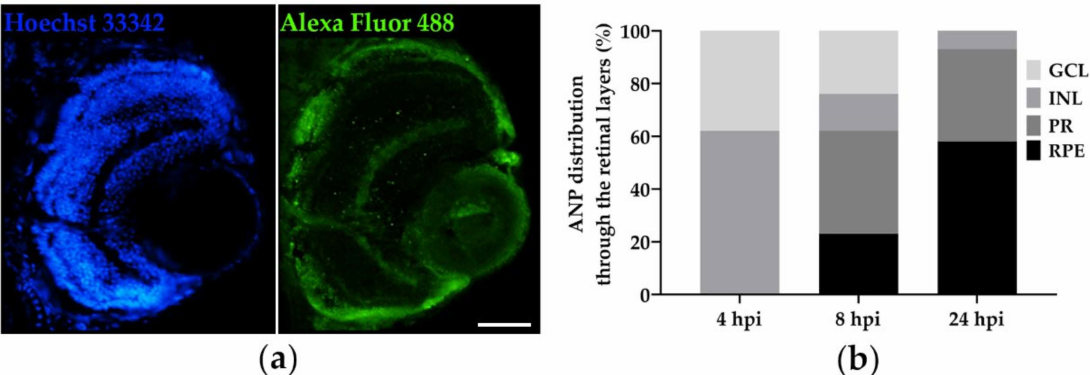
Figure 2. Nanoparticle distribution through retinal layers after intravitreal injection in zebrafish larvae. ( a ) Representative images of a retinal cross-section of a zebrafish larva IVT injected with Alexa Fluor 488-positive polyacrylamide nanoparticles, analysed at 4 h post-injection (hpi). Hoechst staining allows identification of the retinal layers. In FITC channel, the intense green spots clearly highlight the presence of Alexa Fluor 488-positive nanoparticles in the injected eye. ( b ) Quantitative evaluation of the distribution of Alexa Fluor 488-positive polyacrylamide nanoparticles in the retinal layers at different time points. n = 15 injected eyes from 3 independent experiments. GCL, ganglion cell layer; INL, inner nuclear layer; PR, photoreceptors; RPE, retinal pigment epithelium. Scale bar: 50 µ